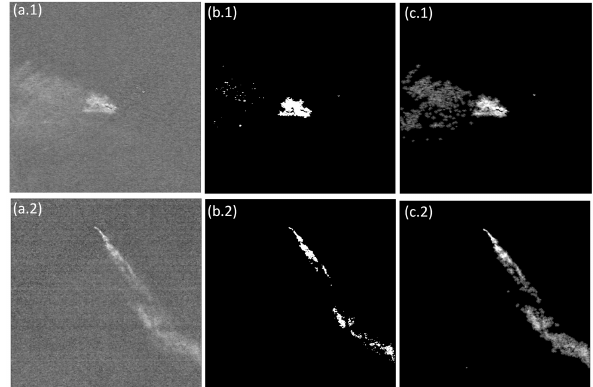
Figure 6. An example of the three-step plume detection and en- hancement algorithm for two methane plumes detected over the Kern River oil field (top panels) and Four Corners (bottom panels), (a.1, 2) original CMF normalized from [0 1] where brightest pixels are associated with the presence of the target gas plume, (b.1, 2) a threshold is set on the CMF using an interquartile range with weight set to 2.5, and (c.1, 2) final plume image after a plume dilation al- gorithm is implemented (see text for